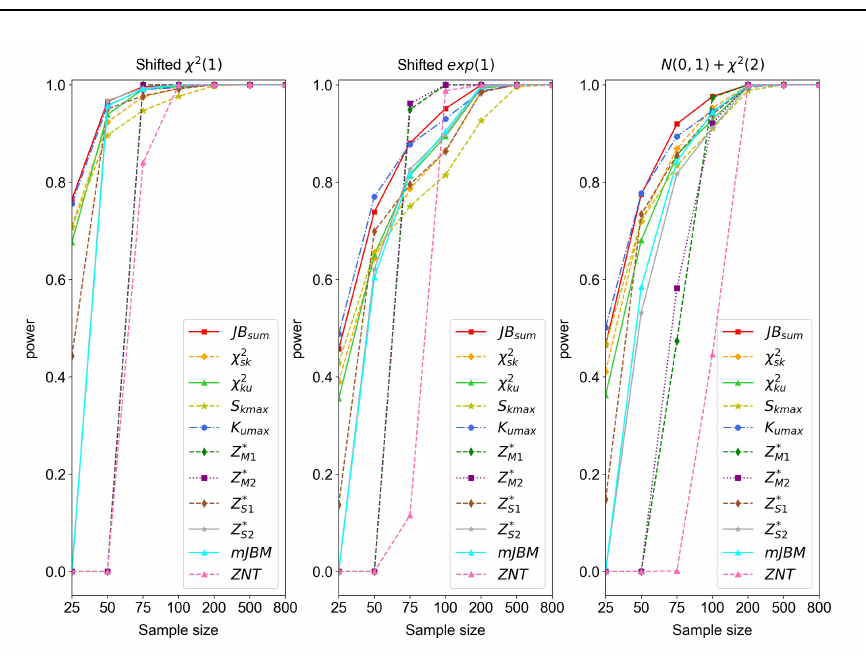
Figure 3. Empirical power of proposed PC-type JB testing compared with other methods ( p =